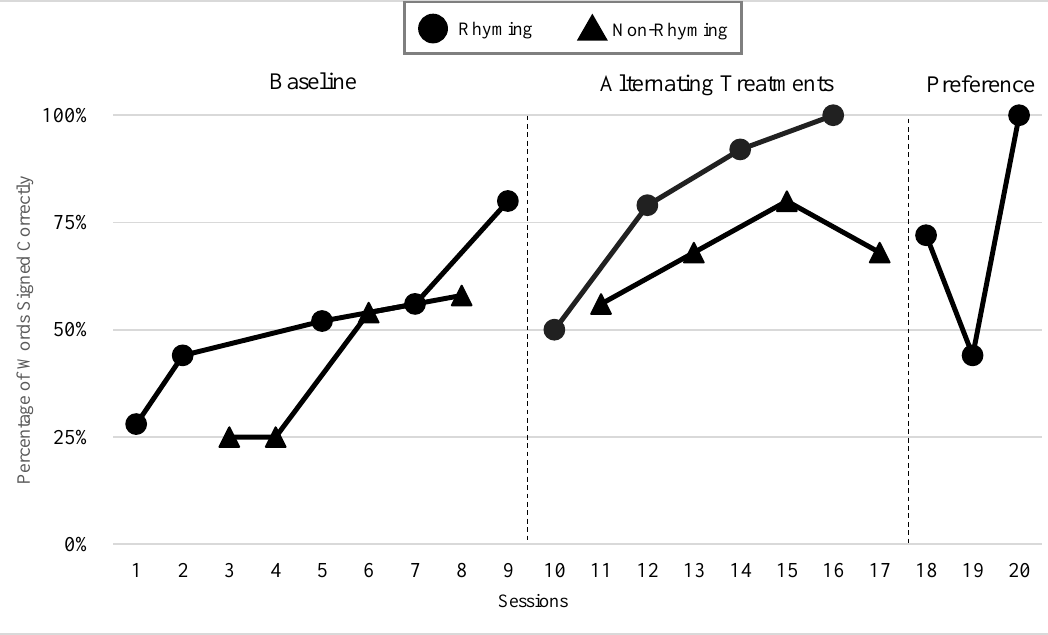
Figure 9. Yair’s Percentage of Words Signed Correctly in Recitation.